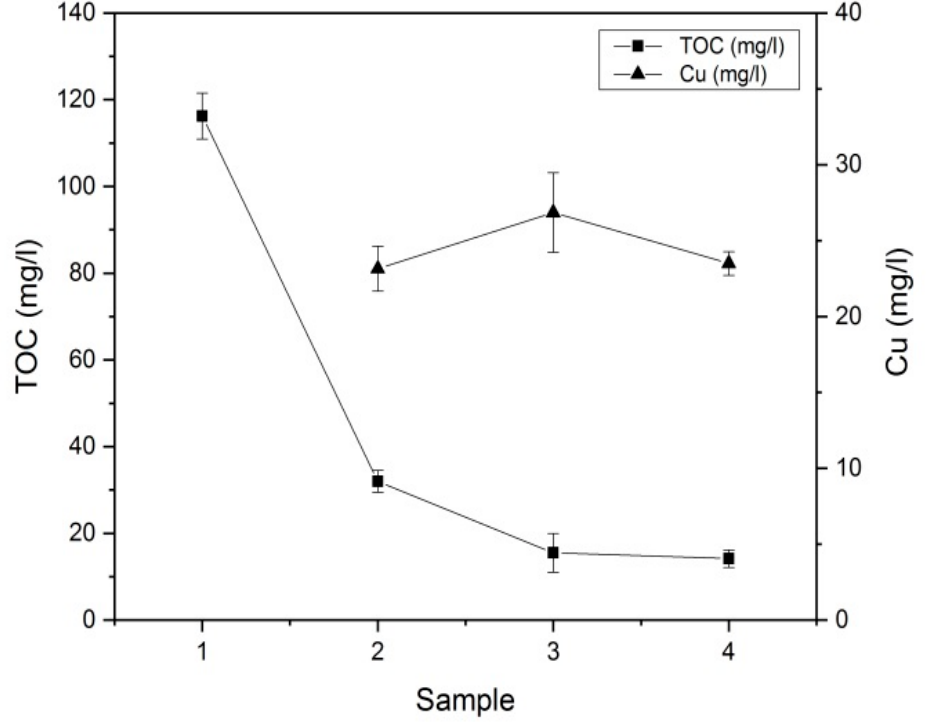
Figure 6. Change in TOC and Cu 2+ depending on the sample (Sample 1: 0.1% Al 2 (SO 4 ) 3 without Cu 2+ , Sample 2: 0.1% Al 2 (SO 4 ) 3 with Cu 2+ , Sample 3: 0.3% Al 2 (SO 4 ) 3 with Cu 2+ , Sample 4: 0.5% Al 2 (SO 4 ) 3 with